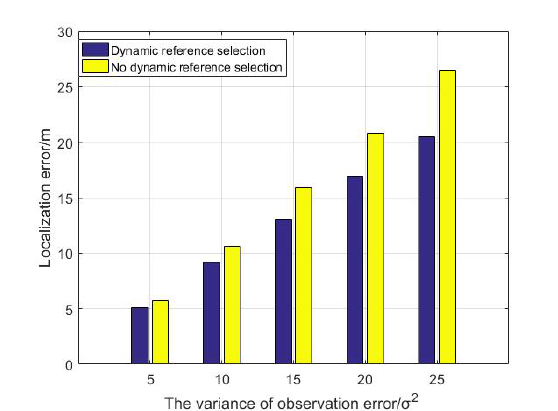
Figure 12. The localization error analysis of dynamic reference selection